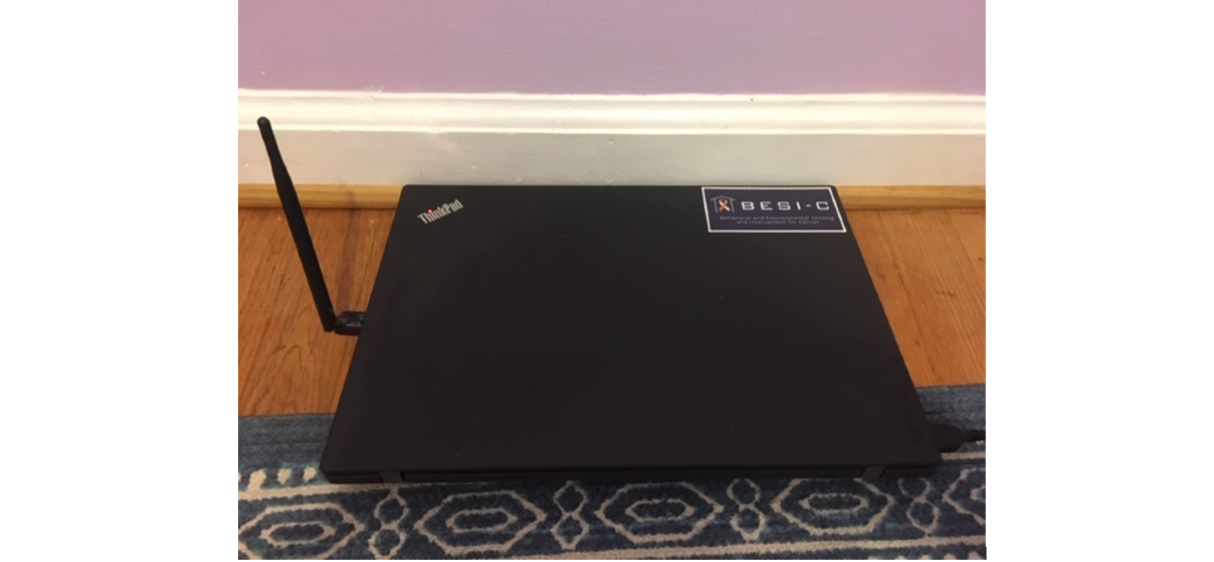
Figure 4. Behavioral and Environmental Sensing and Intervention for Cancer (BESI-C) base station laptop.